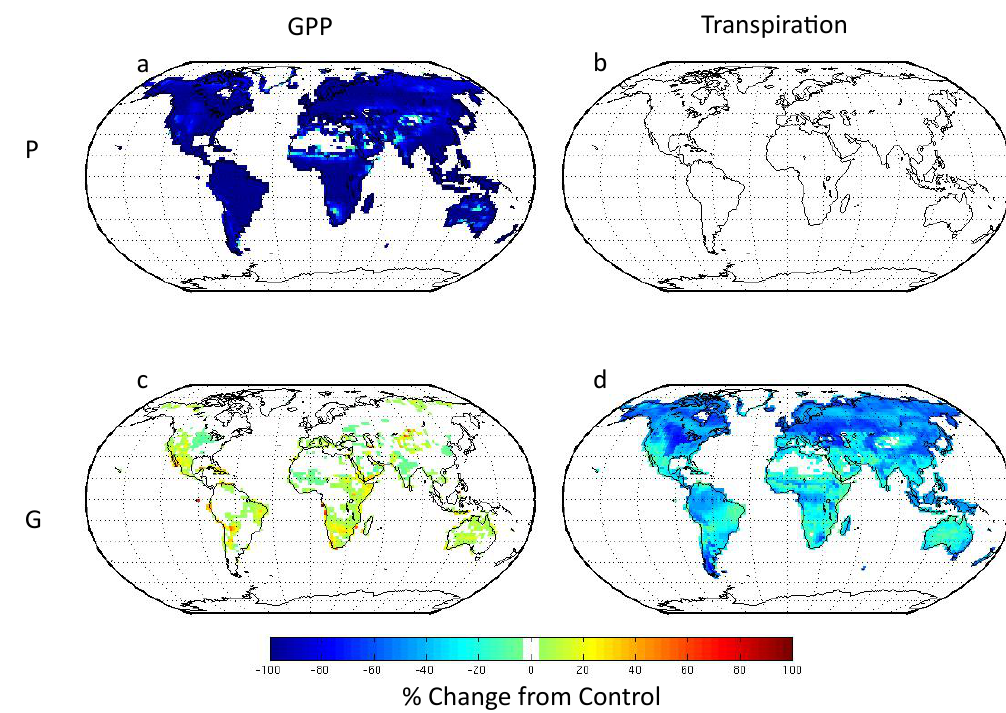
Figure 10 Fig. 10. Mean annual GPP and transpiration predicted in 20-yr CLM simulations run at 100ppb O 3 . Percent differences from control were mapped for the P simulation – (a) – (b) , where a direct change in photosynthesis caused decreases in GPP but did not cause indirect changes in conductance, and for the G simulation – (c) – (d) , where a direct change in conductance caused decreases in transpiration and only affects photosynthesis through feedback